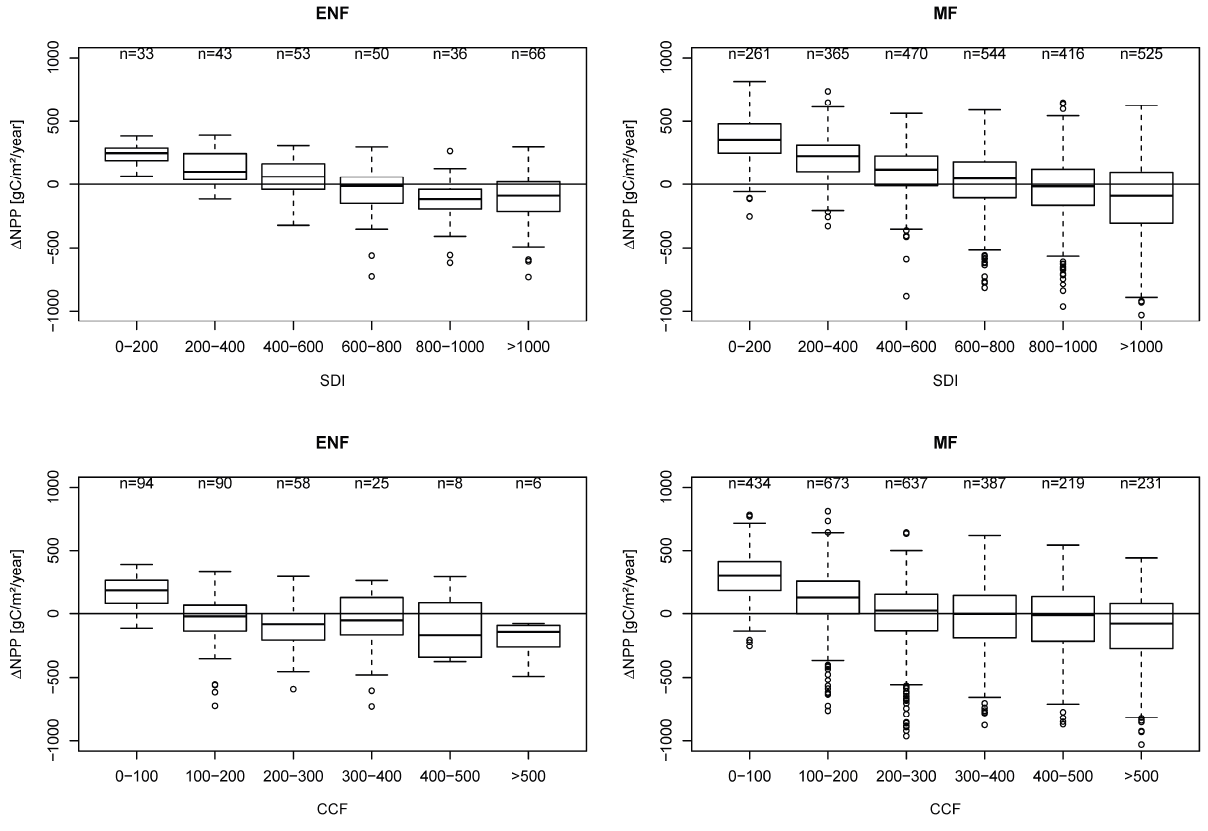
Figure 4. Difference between MODIS NPP and NFI NPP (MODIS minus NFI) grouped by MODIS land cover types (ENF = evergreen needleleaf forest, MF = mixed forest) and stand density measures: SDI ( top ); CCF ( bottom ). Properties of illustration analogous to Figure